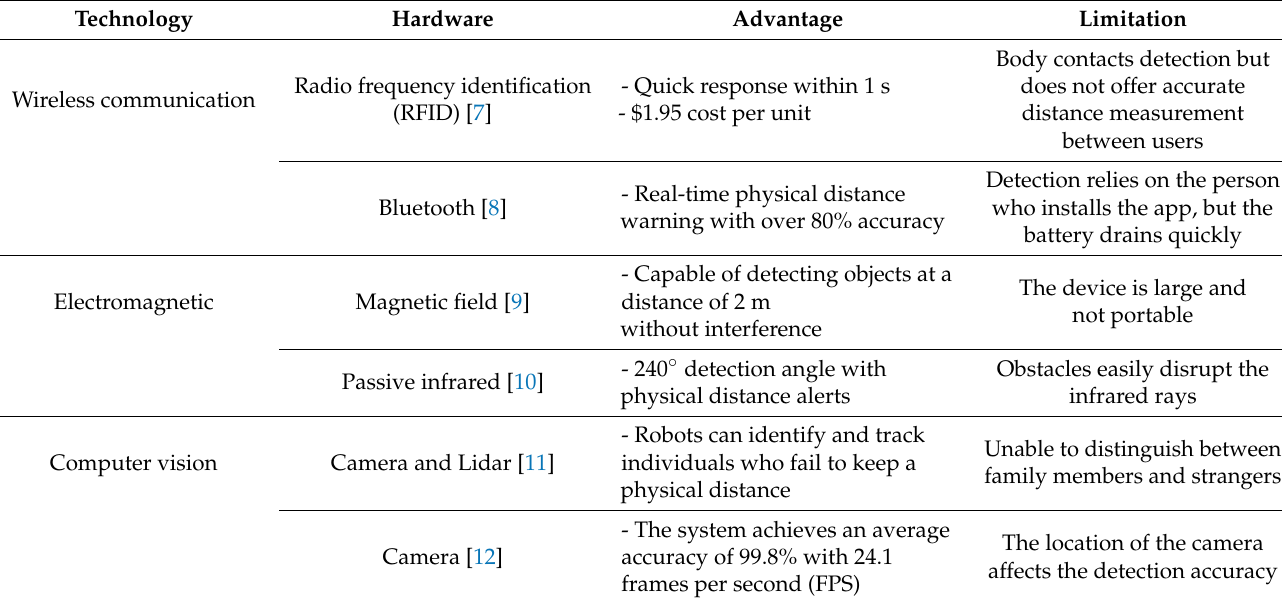
Table 2. Comparison of existing physical distancing